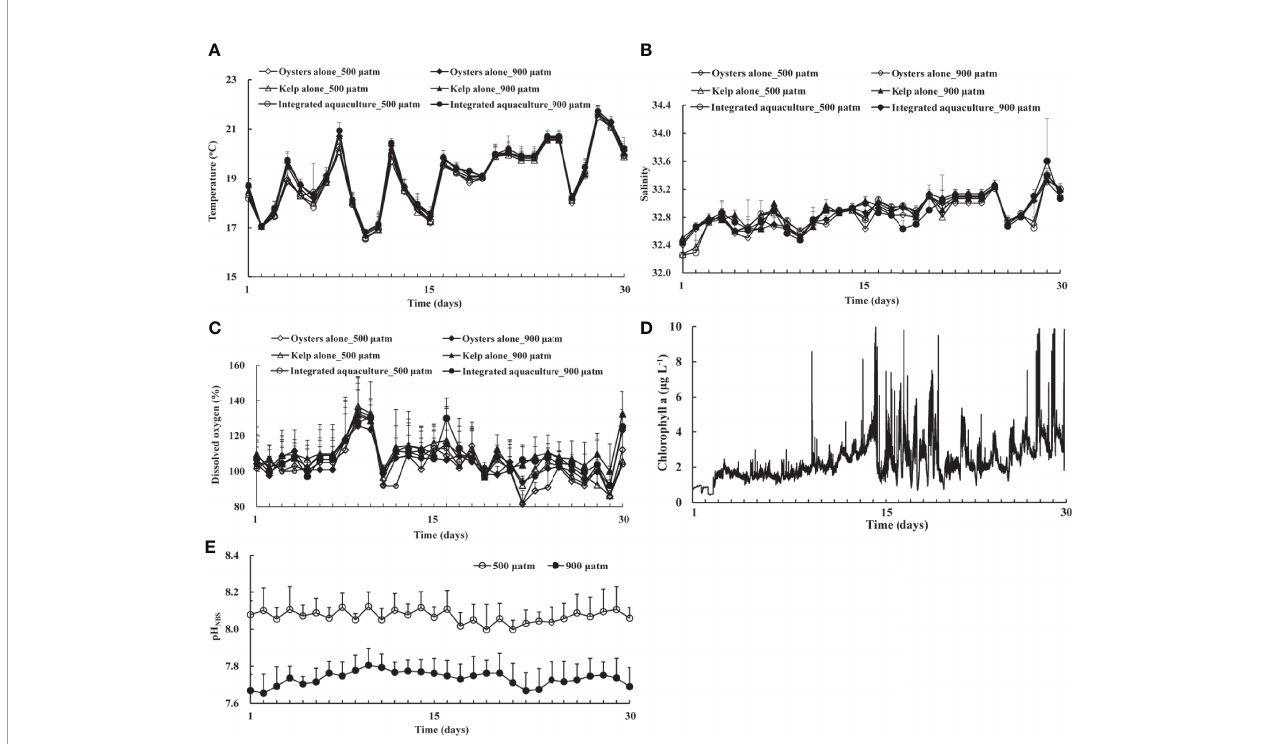
FIGURE 2 | Daily variations of environmental conditions during the 30-day exposure from 14 May to 12 June 2017. (A) Temperature; (B) salinity; (C) dissolved oxygen; (D) chlorophyll a in the ambient seawater; and (E) pH NBS in the in fl ow of experimental units across the treatments. Means ± SD are